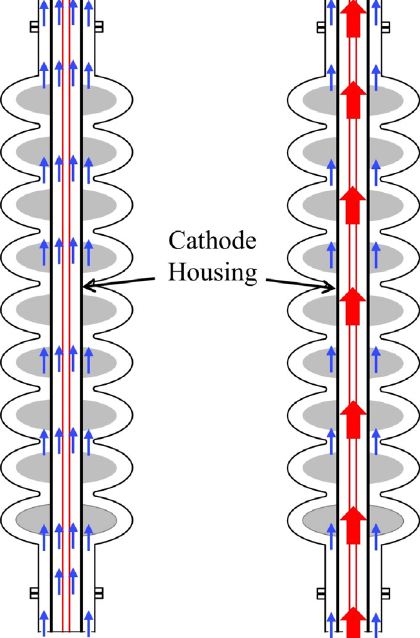
FIG. 13. Schematics of acid flow. Single flow (left): The acid flow in the cavity with no intentional flow in the cathode housing. Dual flow (right): The acid in the cavity and cathode housing using two different inlets. The red wide arrows represent the acid flow in the cathode housing.